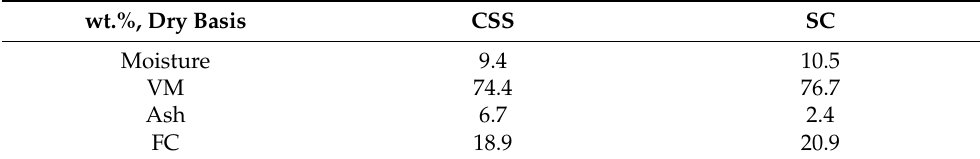
Table 2. Proximate analysis in CSS and SC (wt.%, dry basis) obtained by TGA. wt.%, Dry